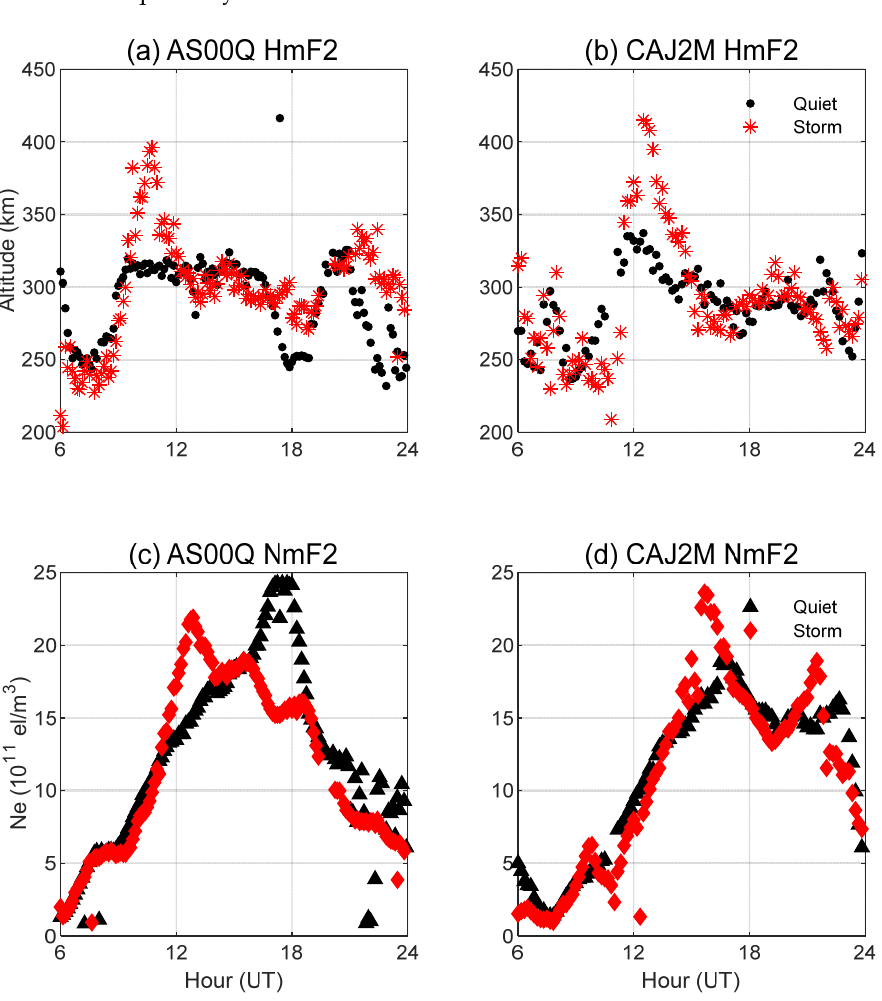
Figure 6. HmF2 and NmF2 comparisons between the storm day and the quiet day at AS00Q and CAJ2M ionosonde stations. In the top row, storm-day and quiet-day HmF2 values are marked by red asterisks and black dots, respectively. In the bottom row, storm-day and quiet-day NmF2 values are represented by red diamonds and black triangles, respectively.